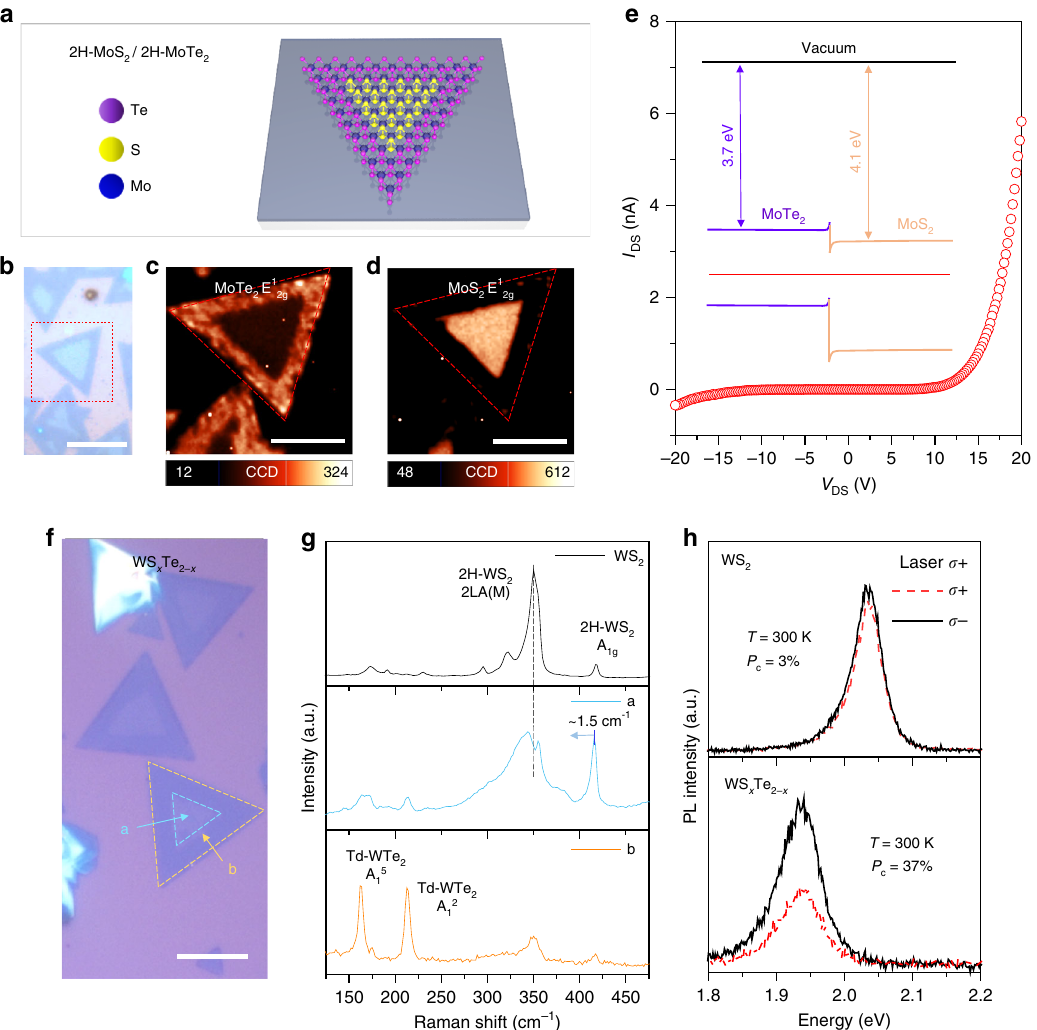
Fig. 6 Formation of MoS 2 /MoTe 2 lateral junction and WS 2 − x Te x alloy. a Schematic of 2H-MoS 2 /2H-MoTe 2 in-plane heterojunction. b – e Optical micrograph ( b ); scale bar, 20 μ m, confocal Raman mapping of E 1 2g 2H-MoTe 2 ( c ), and 2H-MoS 2 ( d ) for MoTe 2 /MoS 2 junction; scale bars, 50 μ m and the corresponding diode I – V curve ( e ). A clear diode behavior with the band diagram of the MoTe 2 /MoS 2 heterostructure reveals a type-II junction. For electrical measurements, source (MoTe 2 ) and drain (MoS 2 ) electrodes were fabricated by depositing 5/50 nm Cr/Au. f Optical micrograph of tellurized monolayer WS 2 fl akes. WTe 2 /WS 2 − x Te x junction; scale bar, 20 μ m. g Raman spectra from each region of a and b in f . The Raman spectrum of 2H-WS 2